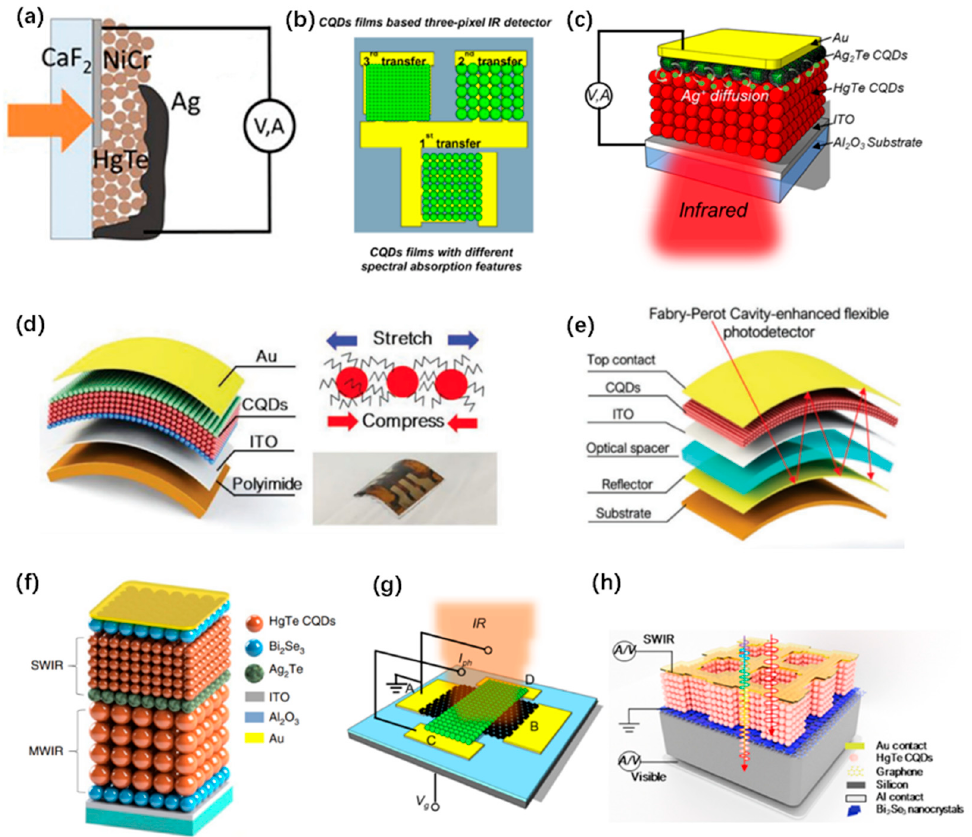
Figure 8. ( a ) Schematic diagram of the device structure. Reprinted with permission from Ref. [111].